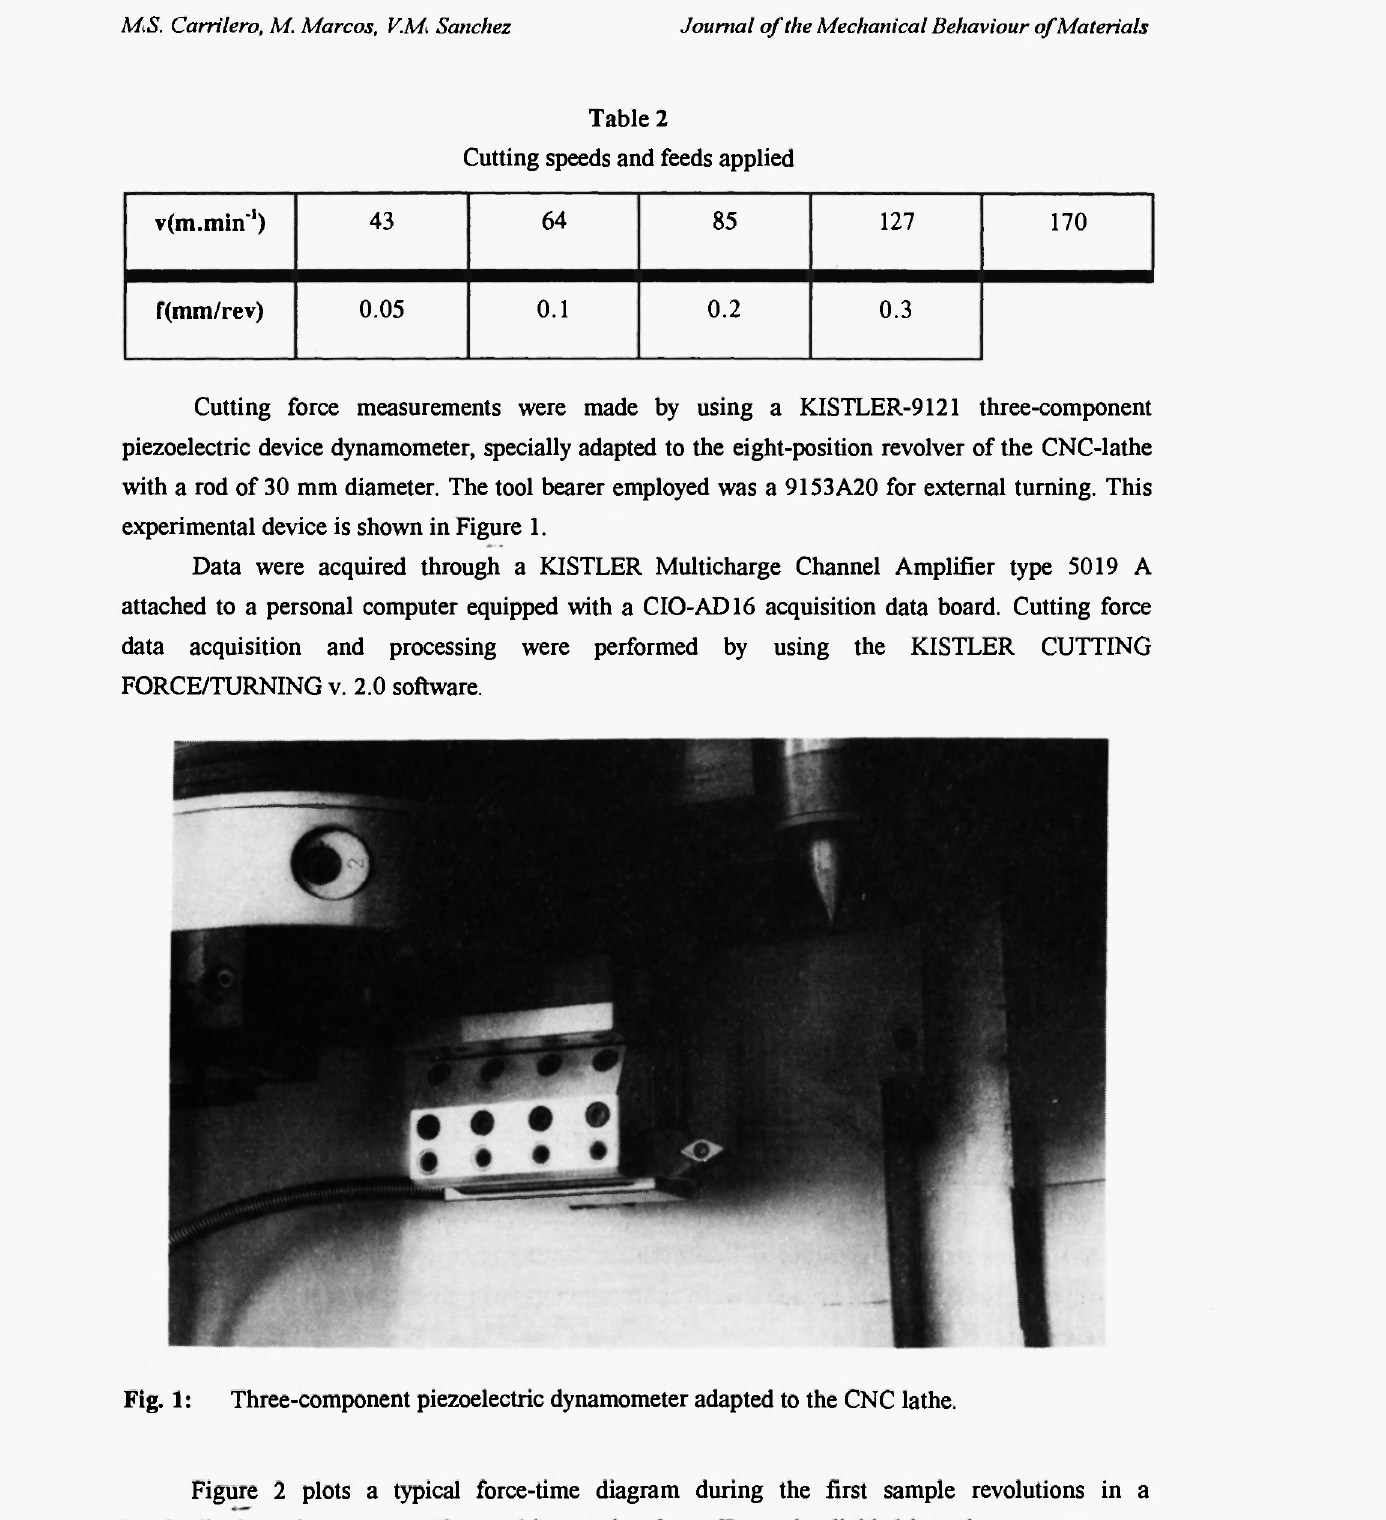
Fig. 1: Three-component piezoelectric dynamometer adapted to the CNC